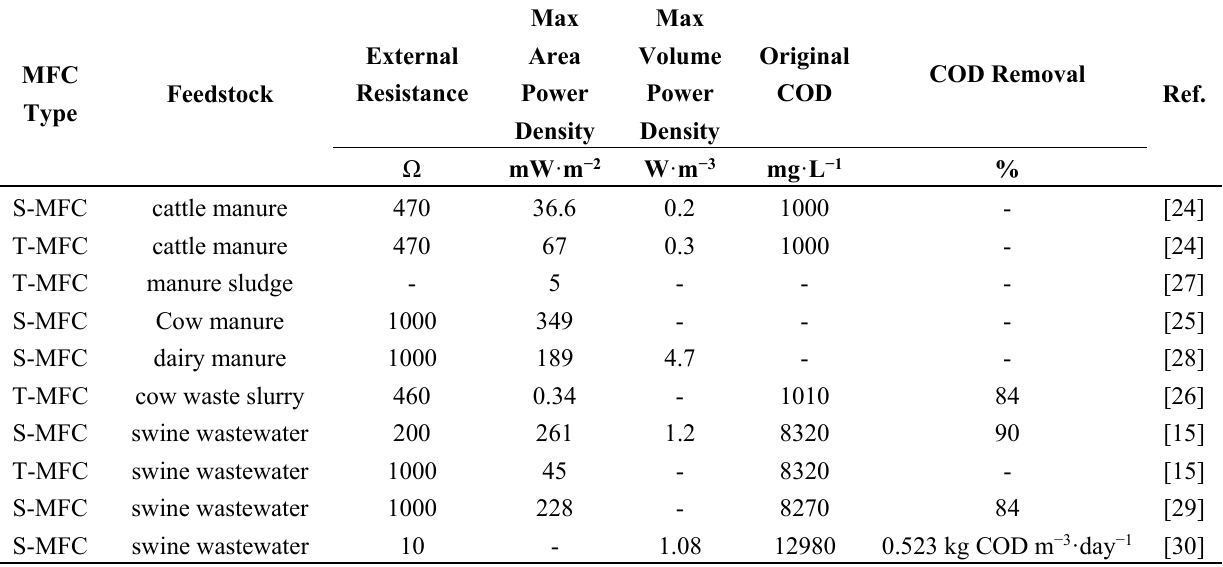
S—single-chambered;